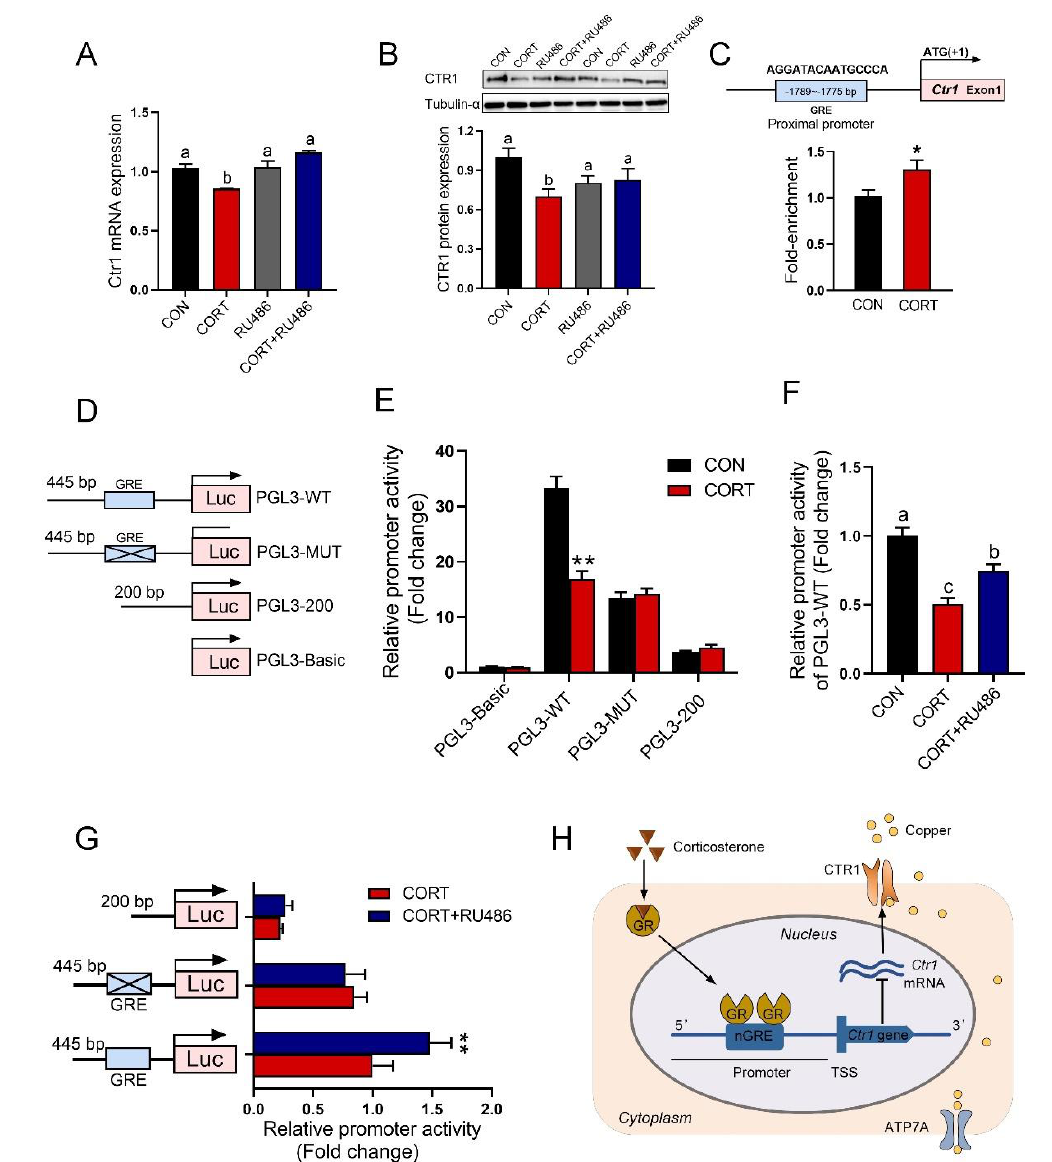
Figure 6. GR binding to the promoter of the Ctr1 gene reduces its protein expression. (A, B) mRNA expression and pro- tein content of CTR1 in Caco- 2 cells with corticosterone (CORT, 10 μM) treatment in the presence and absence of GR an- tagonist RU486 (10 μM) for 24 h (n = 3). (C) Schematic representation of GR transcription factor binding promoter of Ctr1 (up) and ChIP-PCR assay was used to measure the binding of GR on Ctr1 promoter in the Caco-2 cells after 24 h treatment